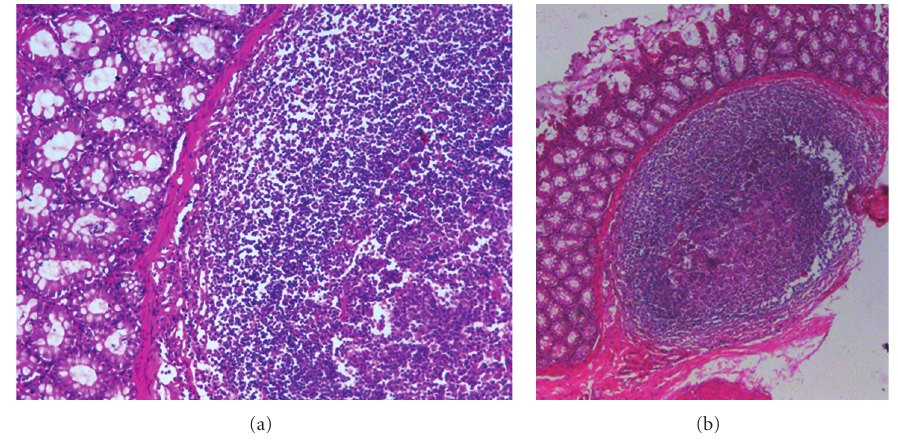
Figure 5: Granulomatous colitis of a cat with e ff usive FIP showing infiltration of inflammatory cells.